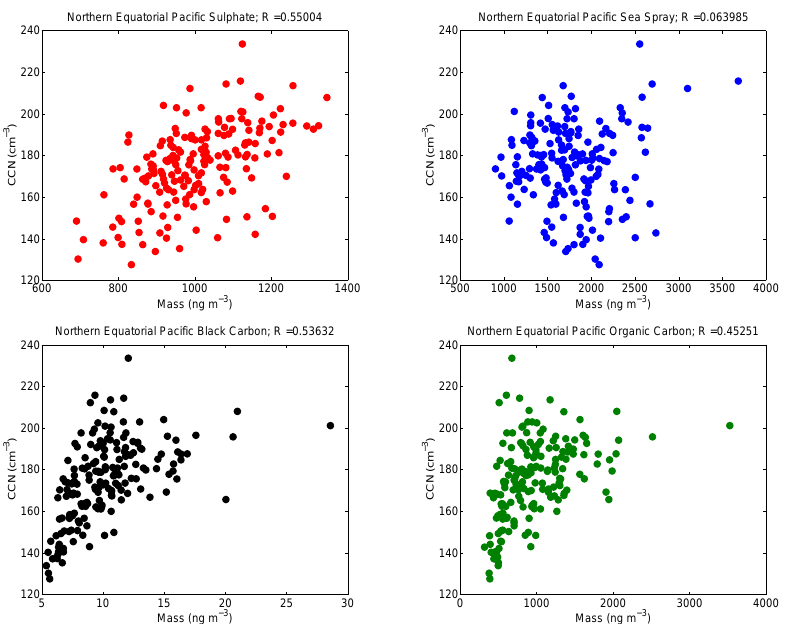
Figure 6. Scatter plot of simulated monthly mean CCN concentration vs. accumulation-mode mass of (a) sulfate, (b) sea spray, (c) black carbon, and (d) organic carbon, in the Northern Equatorial